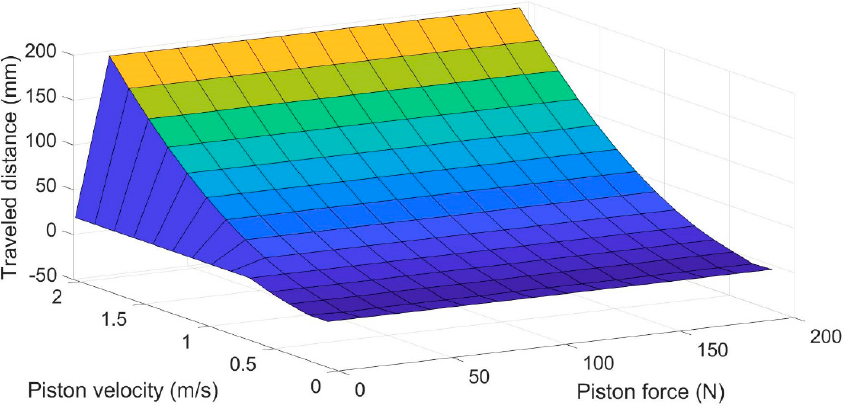
Figure 11 . Correlation between the piston’s velocity, the piston’s force, and the travelled distance of the robot